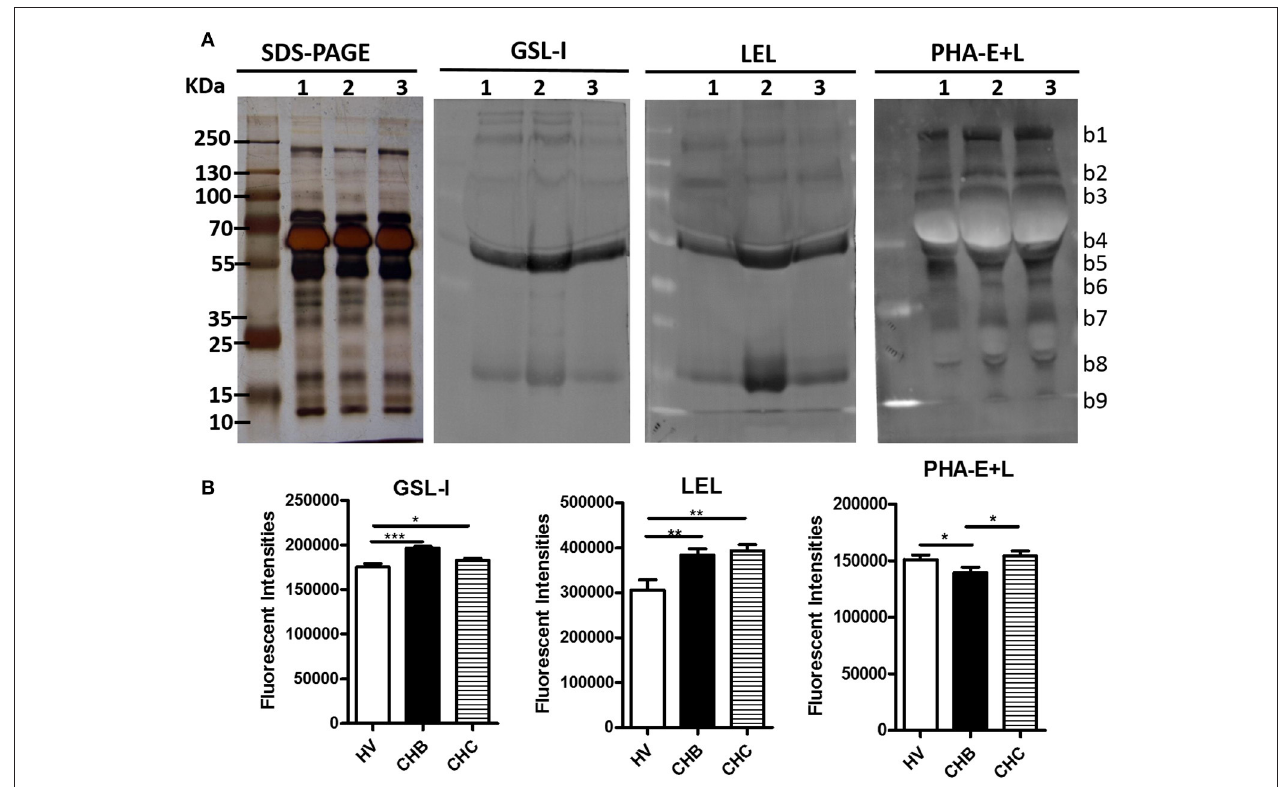
FIGURE 3 | Validation of the differential expressions of the glycopatterns in the sera from CHB, CHC patients, and HV (A) The binding pattern of glycoproteins from the three groups of sera pooled samples using 3 lectins (GSL-I, LEL, and PHA-E + L). Lane 1, HV; lane 2, CHB patients; lane 3, CHC patients. Blot affinity results showed nine apparent bands belonging to different molecular weights, ranging from 10 to 250 kDa, which were marked as b1 − b9, respectively. (B) Summed fluorescence intensities (read by Image J) along the distance from lane 1 to lane 9 for each lectin binding to